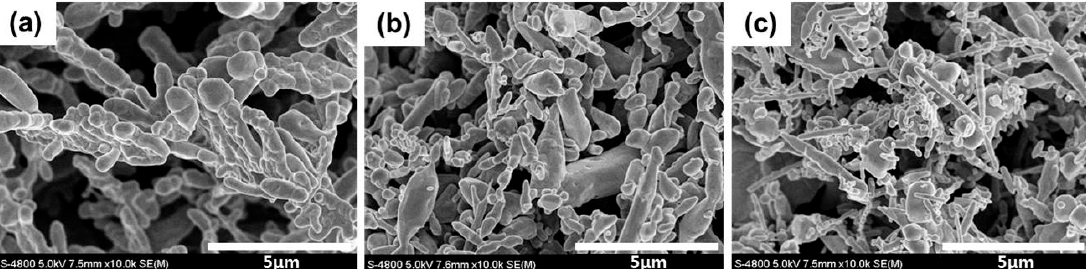
Figure 5. Microstructures of recovered Ag according to the variation in the concentration of the added water: ( a ) 0 M, ( b ) 5.0 M, and ( c ) 20.8 M.